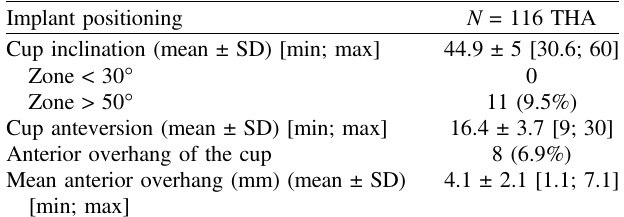
Table 3. Acetabular implant positioning at the last follow-up. Implant positioning